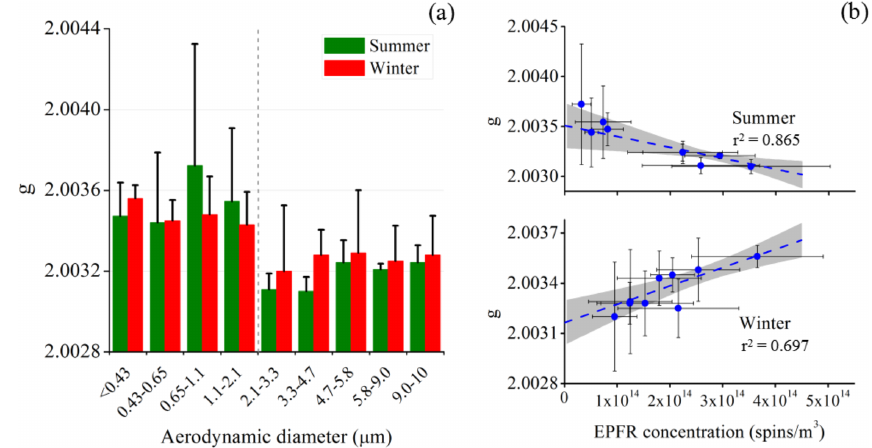
Figure 2. A g factor comparison. (a) Comparison of g factors of EPFRs in different particle sizes in different seasons. (b) Correlation analysis of g factors and concentrations of EPFRs in summer and winter PM. The gray areas in the figure represent 95% confidence intervals.